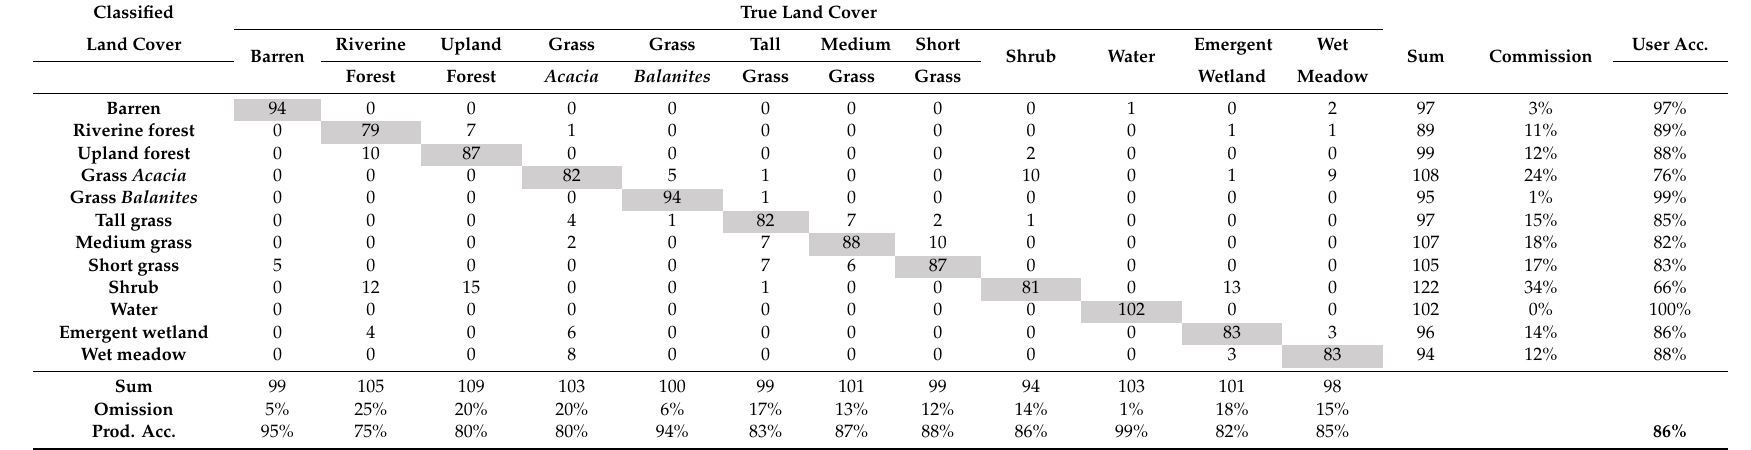
Table 3. Confusion (i.e., error) matrix for land cover classification of the Masai Mara National Reserve. Numbers represent pixels (10 × 10 m each). Numbers in gray cells represent pixels from the validation dataset that were correctly identified by the Random Forests classifier. Numbers falling outside the gray cells represent misclassified